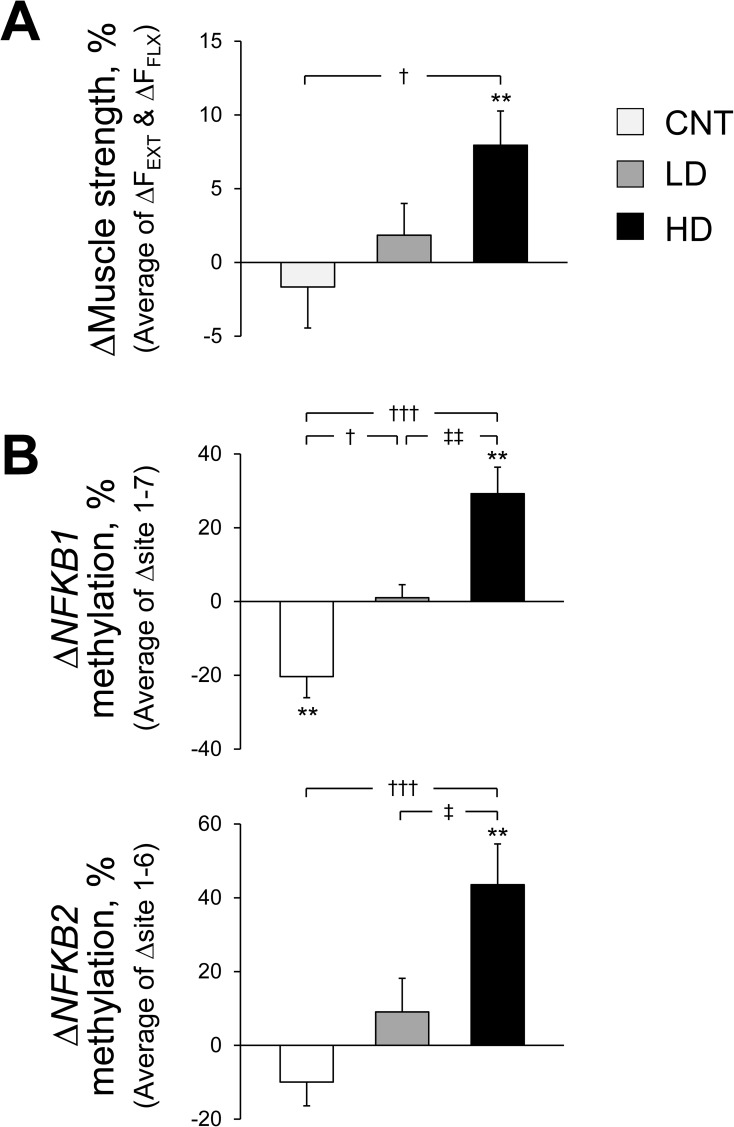
Percent changes after training in muscle strength (A) and methylation of the NFKB1 and NFKB2 promoter regions assessed by pyrosequencing (B). The data were adjusted for pretraining values by ANCOVA. The mean and SE bars are presented for 12, 12, and 13 subjects in the IWT control (CNT), IWT + low-dose (LD) and IWT + high-dose milk product intake (HD) groups, respectively. **Significant differences from pretraining values, P<0.01. Significant differences from the CNT group, †P<0.05 and †††P<0.001. Significant differences from the LD group, ‡P<0.05 and ‡‡P<0.01. A: Average percent changes in isometric knee extension (ΔFEXT) and flexion (ΔFFLX) forces are presented. B: Average percent changes in CpG sites 1–7 for NFKB1 (upper) and average percent changes in CpG sites 1–6 for NFKB2 (lower) are presented.